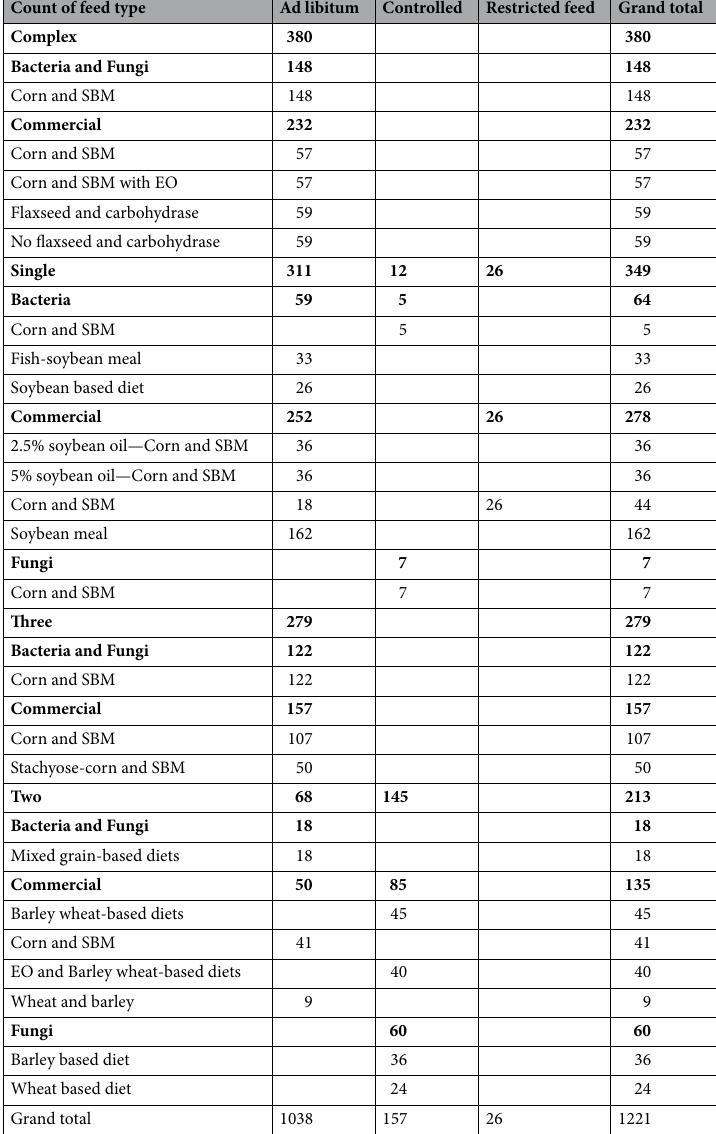
Table 3. Consolidated table with feed type and method, enzyme type and its origin. Flow of information through the stages of the meta-analysis.